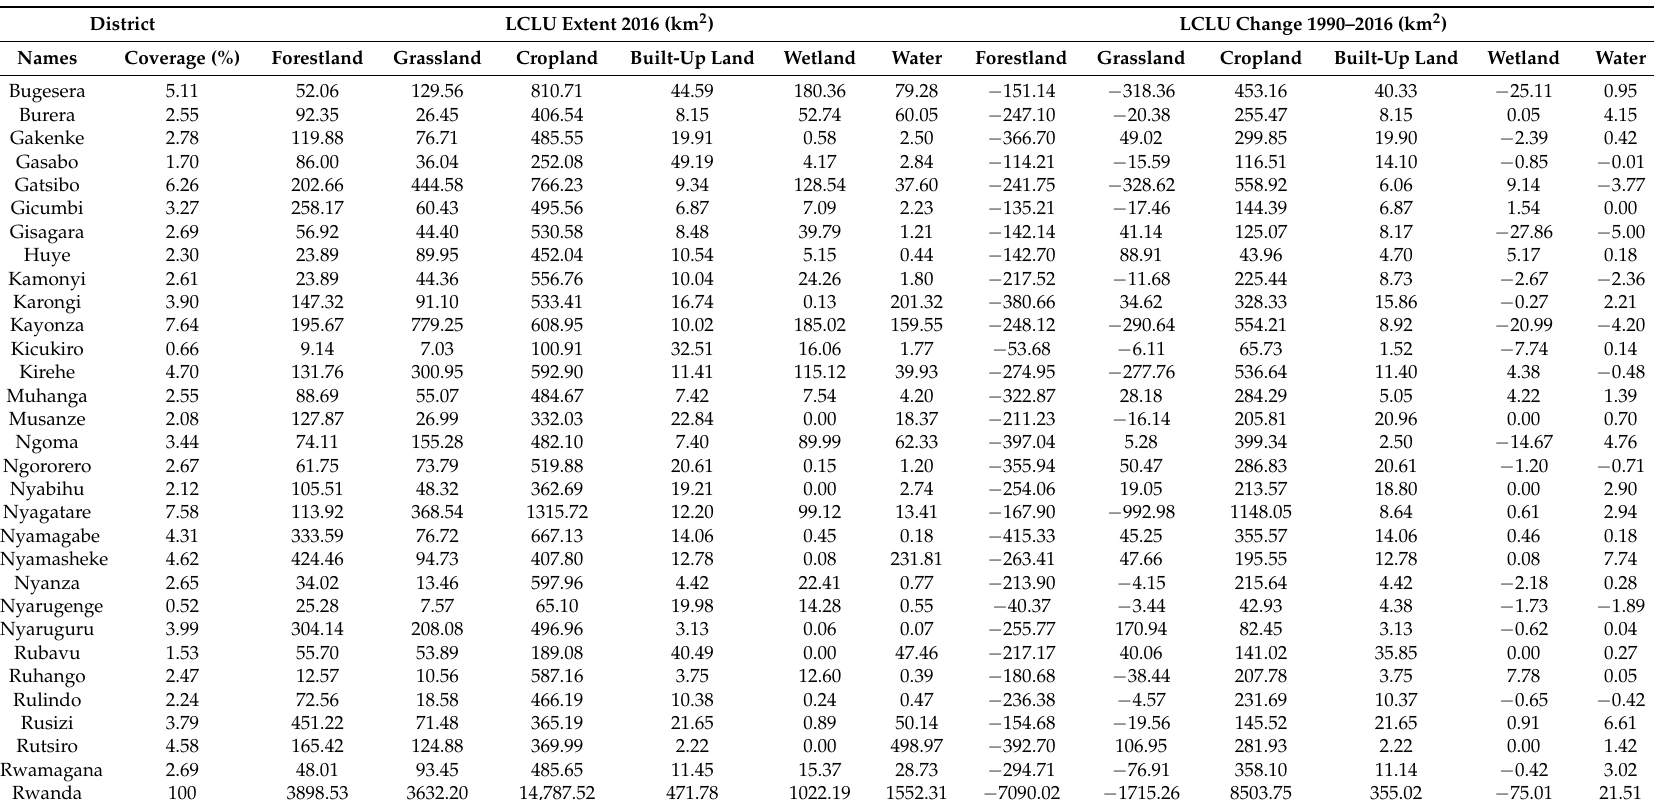
Table A1. Land cover/use types per district in 2016 and their changes